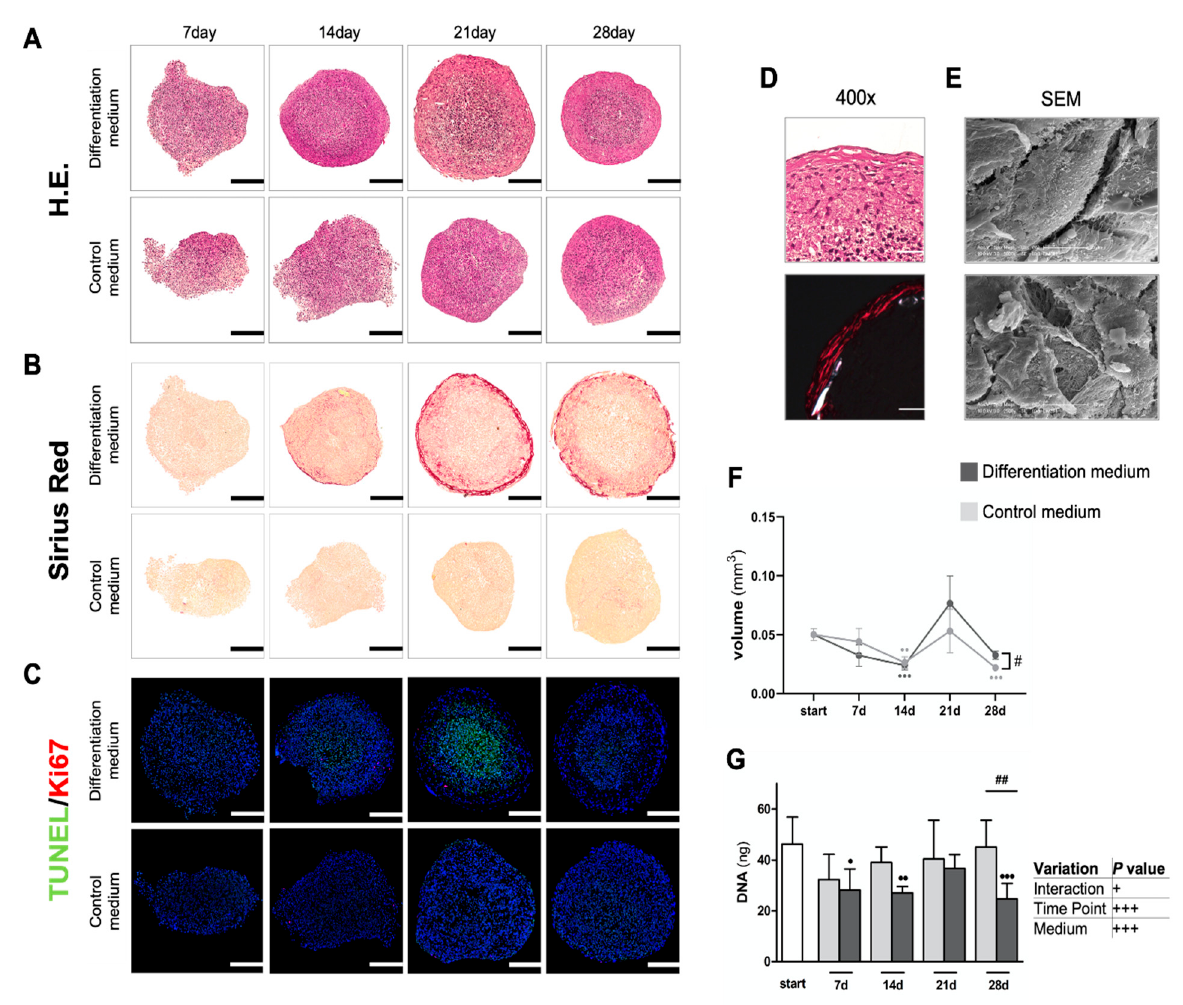
Figure 1. General microscopic appearance of spheroids, next to collagen content and cell death. ( A ) Hematoxylin–Eosin (H.E.) overview of staining, showing nuclei in violet blue and cytoplasm and ECM in shades of pink. ( B ) Sirius Red staining of collagens. ( C ) TUNEL/Ki67 co-staining to detect apoptotic cell death and proliferation. Representative stainings are shown ( n = 3), scale bars represent 200 µm. ( D ) 400× g magnifications of the rim region of HE-stained differentiating spheroids at day 28 with polarized light micrograph of Sirius Red staining underneath. Scale bars are 50 µm. ( E ) Representative SEM images of the outer spheroid layer, cultured for 28 days in differentiation medium. ( F ) Spheroid volume determination by micro-CT. Significant differences were calculated by 2-way ANOVA ( n = 6) followed by Tukey’s post hoc test of BCY-transformed data. ( G ) Total DNA analyses of the spheroids using BCY-transformed data with two-way ANOVA ( n = 6), followed by Tukey’s post hoc test, next to tabular overview. # p < 0.05, ## p < 0.01 as indicated; • p < 0.05,